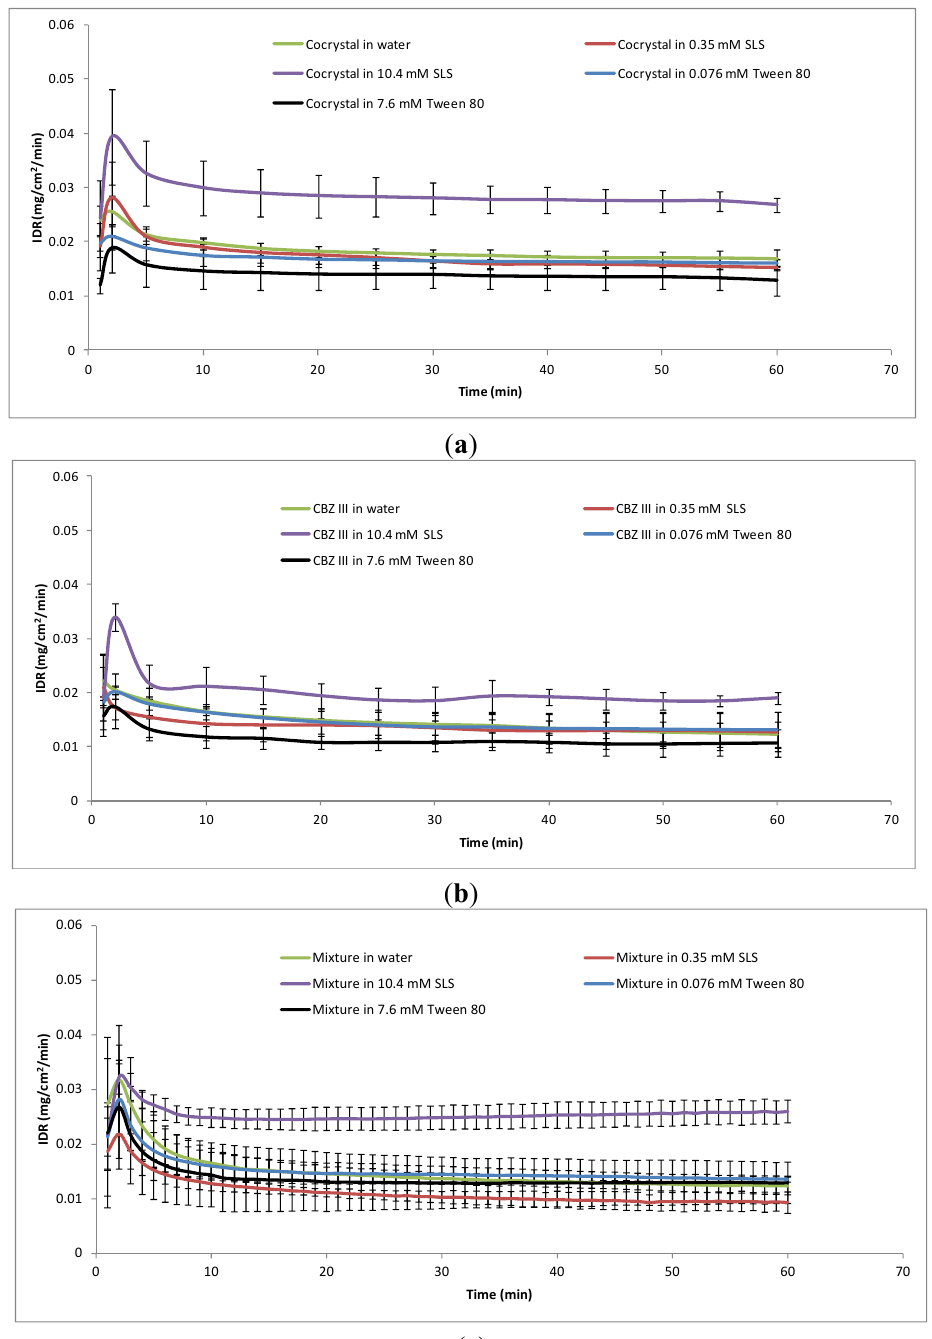
Figure 4. Dissolution profiles of test samples at different dissolution media. ( a ) CBZ–NIC cocrystal; ( b ) CBZ III; ( c ) equimolar physical mixture of CBZ III and